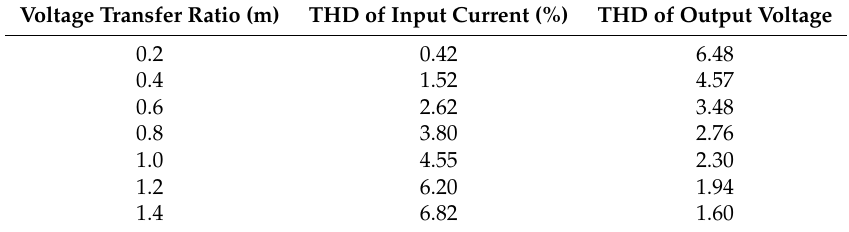
Figure 10. The simulation results of line-to-line output voltage, phase output voltage and output current. Table 7. The THD of input current and output voltage according to the voltage transfer ratio.